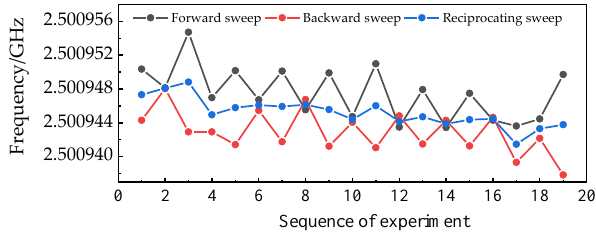
Figure 4. Experimental results of “ in phase ” frequency.